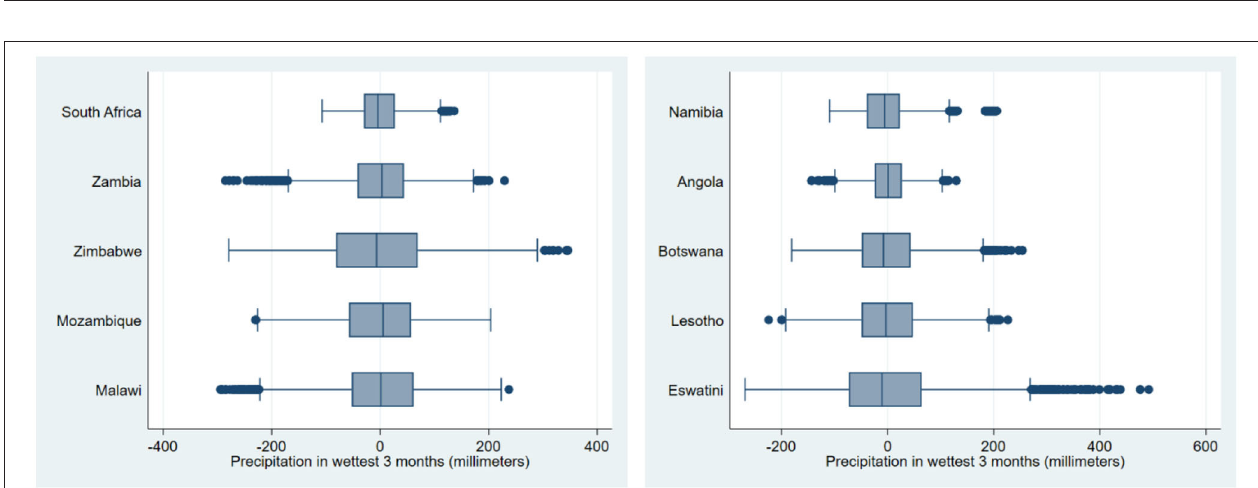
FIGURE 6 | Fourty year trend in change to annual precipitation, 1975–2015, millimeters. Source: Authors, using Princeton Global Forcings daily precipitation. Hash marks show areas with < 10% joint statistical significance on the sum of the parameters associated with yr and yr 75 from Equation (1).